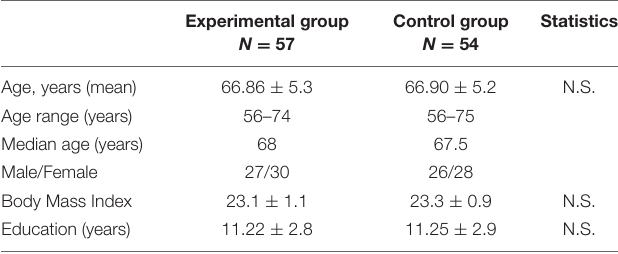
TABLE 1 | Baseline demographic characteristics of experimental (Cognigrape R (cid:13) ) group and control (placebo) group of participants to the 12 weeks study.